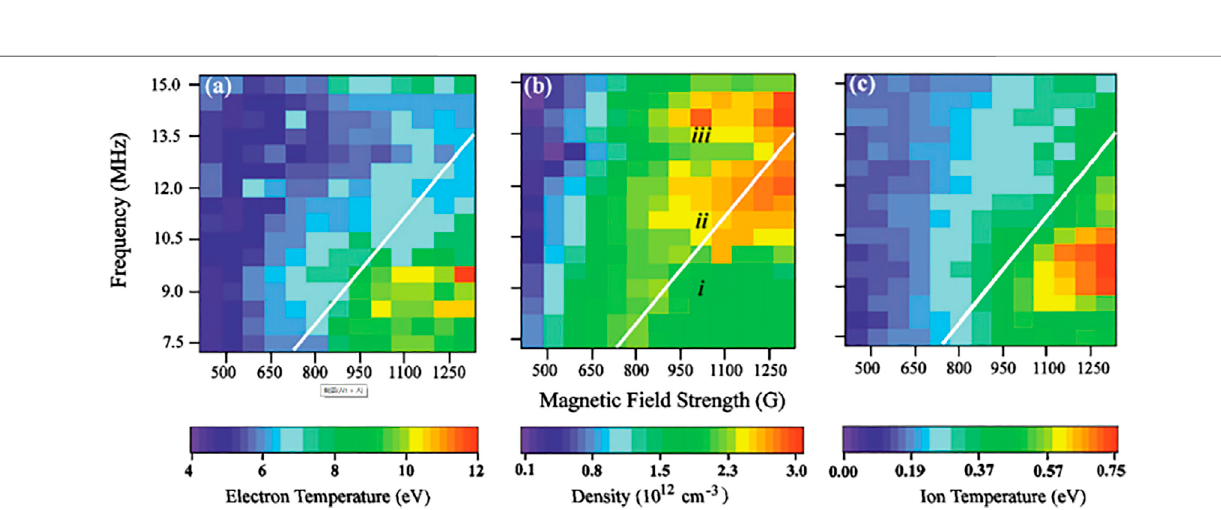
Frontiers in Physics |